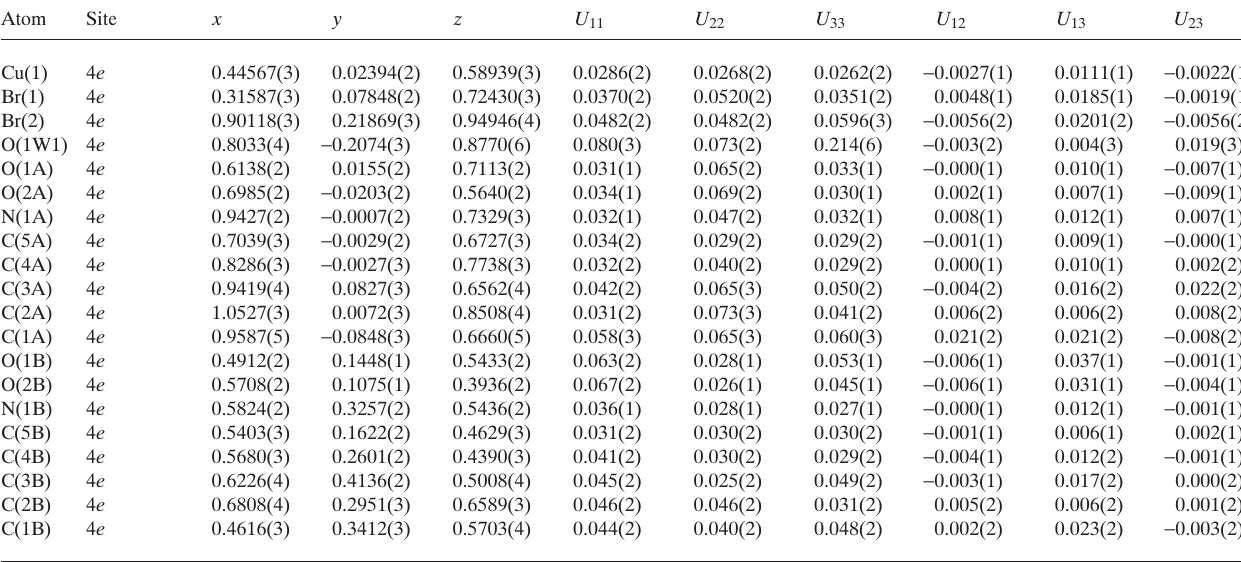
Table 3. Atomic coordinates and displacement parameters (in Å 2 ) .